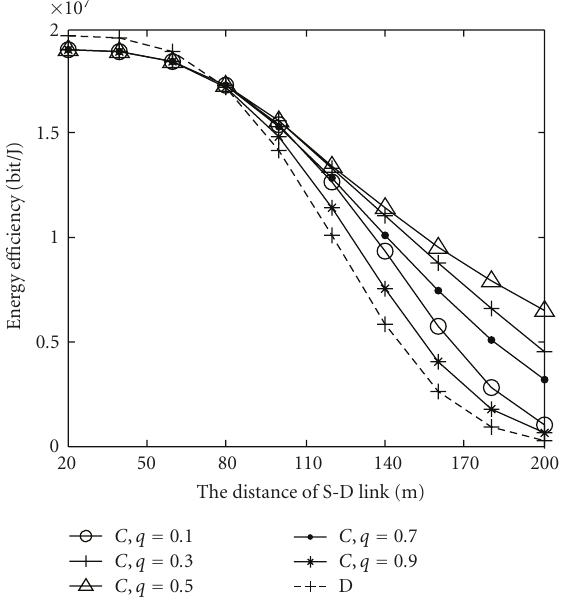
Figure 2: Energy e ffi ciency versus the S-D distance for di ff erent relay locations.